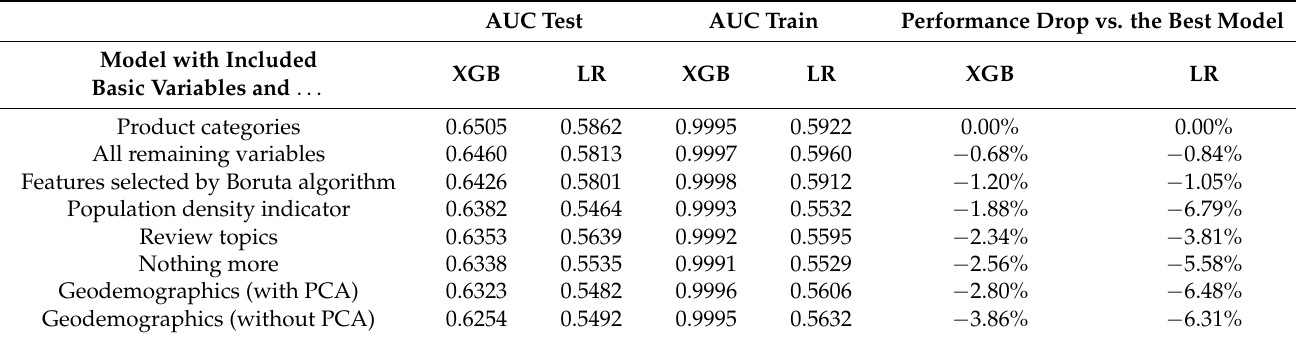
Table 3. AUC values for XGBoost and logistic regression models. AUC Test AUC Train Performance Drop vs. the Best Model